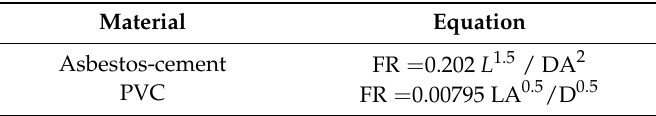
Table 4. Results for Evolutionary Polynomial Regressions (EPR).